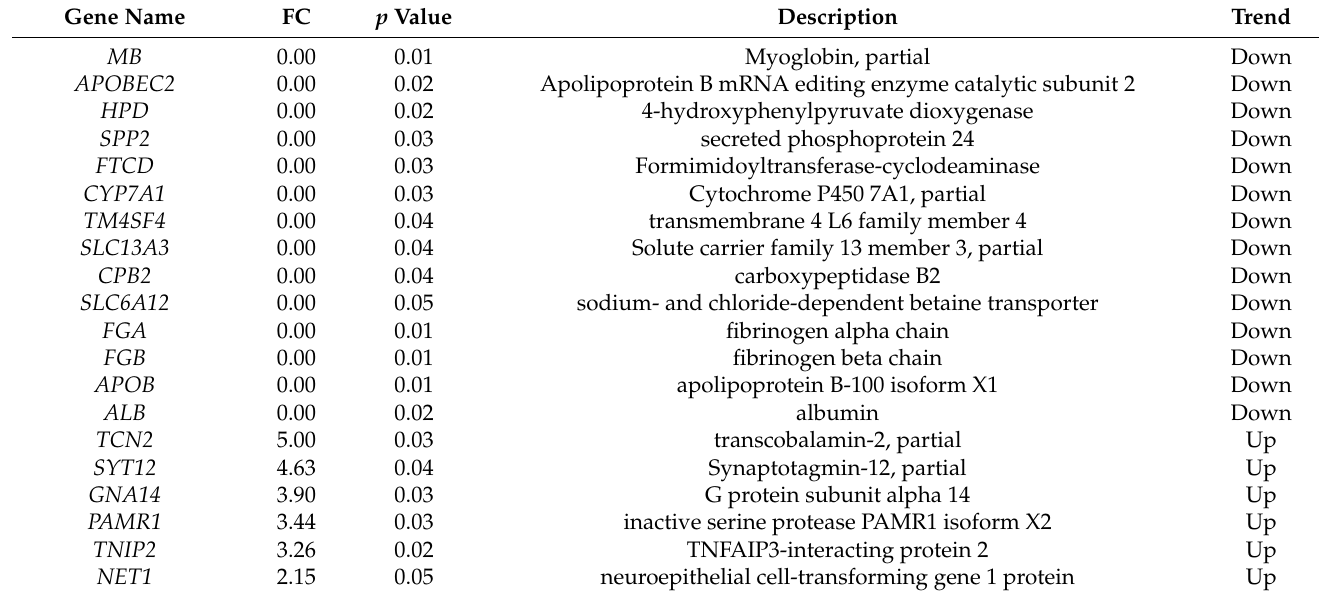
Table 3. The top 20 known differentially expressed genes between 66 wk and